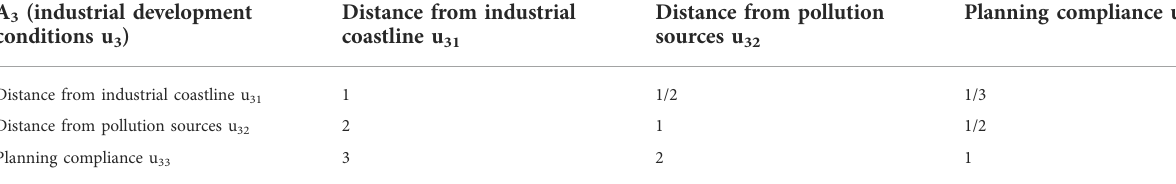
TABLE 8 Quantitative judgment of the relative importance of indexes for industrial development